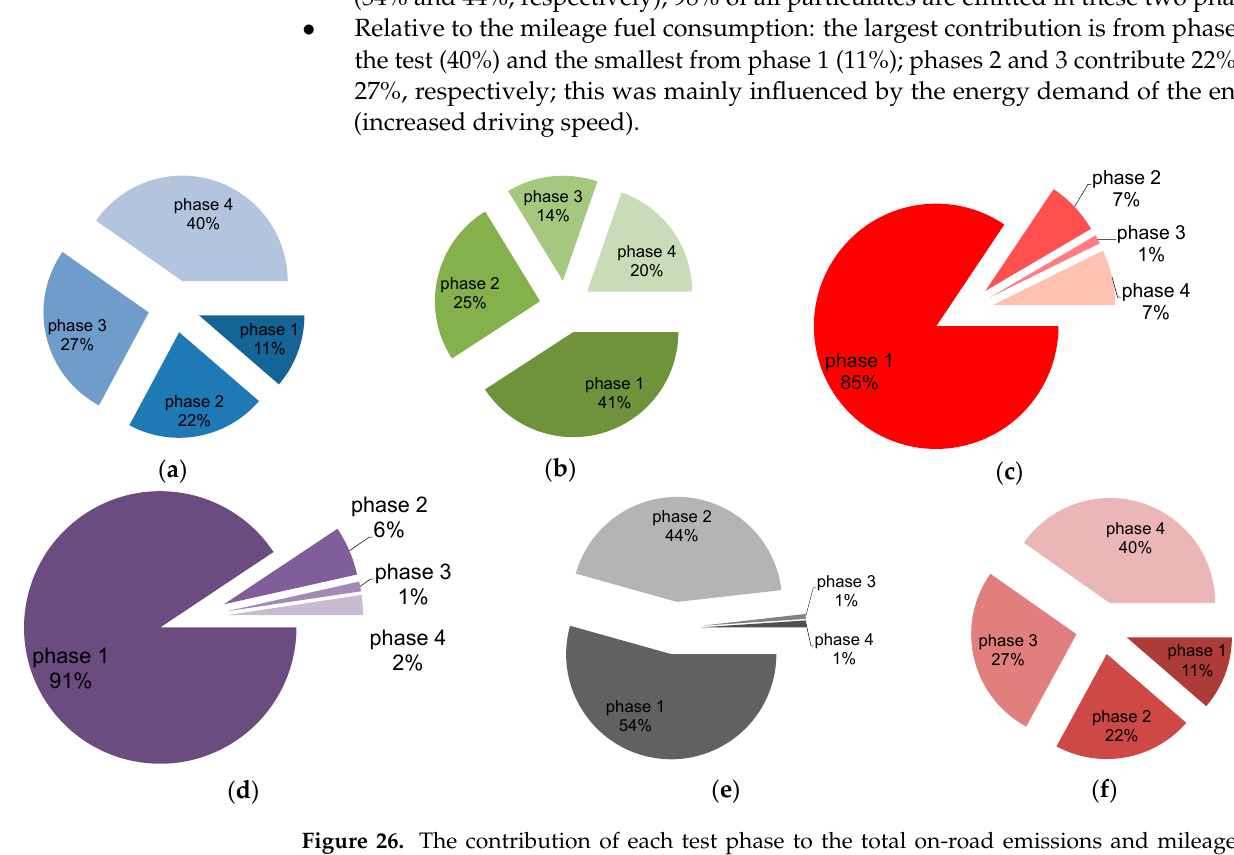
Figure 26. The contribution of each test phase to the total on-road emissions and mileage fuel consumption of the WLTC test during HEV testing: ( a ) carbon dioxide, ( b ) carbon monoxide, ( c ) nitrogen oxides, ( d ) hydrocarbons, ( e ) particle number, and ( f ) fuel consumption.